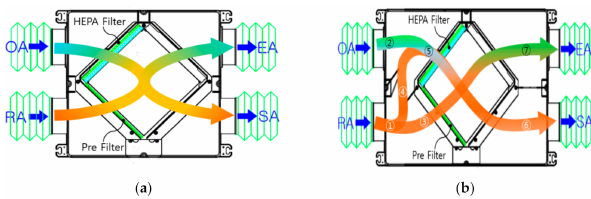
Figure 3. Ventilation methods: ( a ) conventional; ( b ) mixed